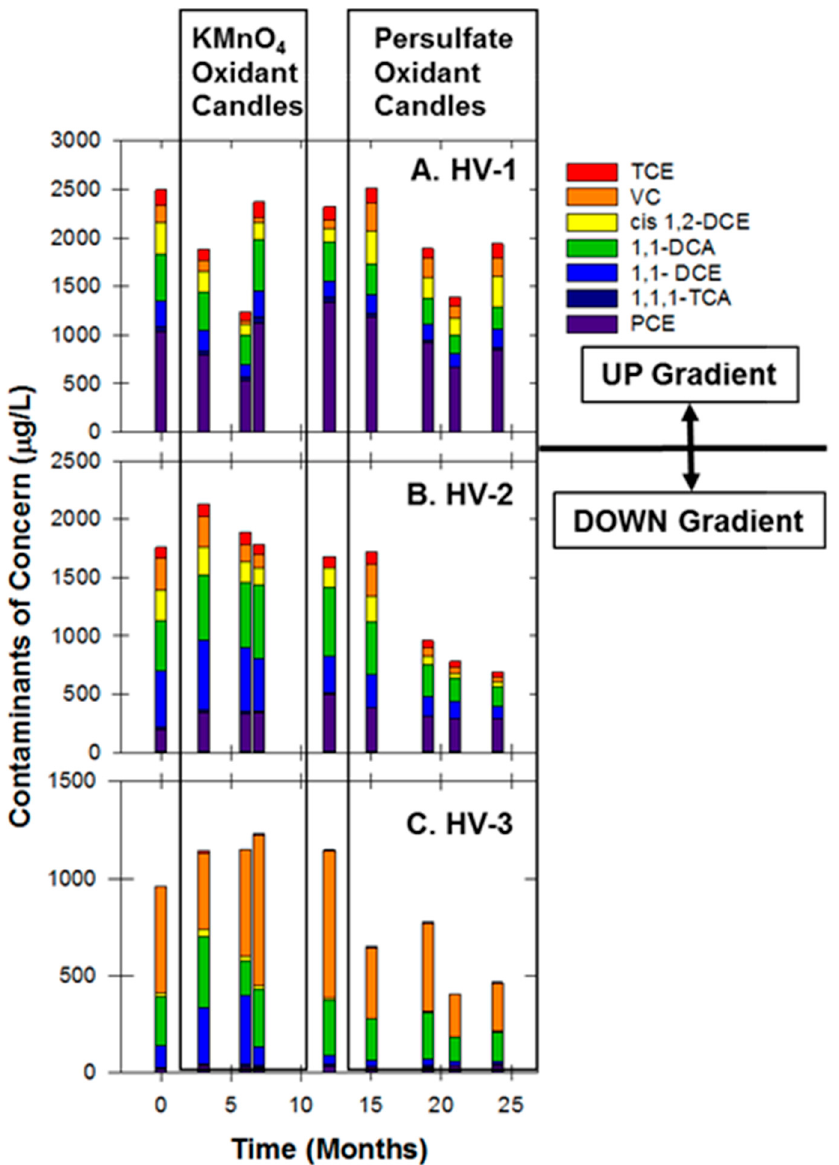
Figure 10. Temporal changes in contaminants of concern concentrations following installation of permanganate oxidant candles followed by persulfate oxidant candles at the Hoover site.